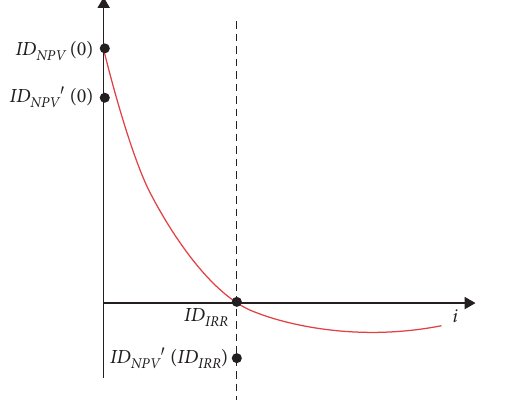
Figure 3: NPV curve of transnational investment project under decreasing NCF.